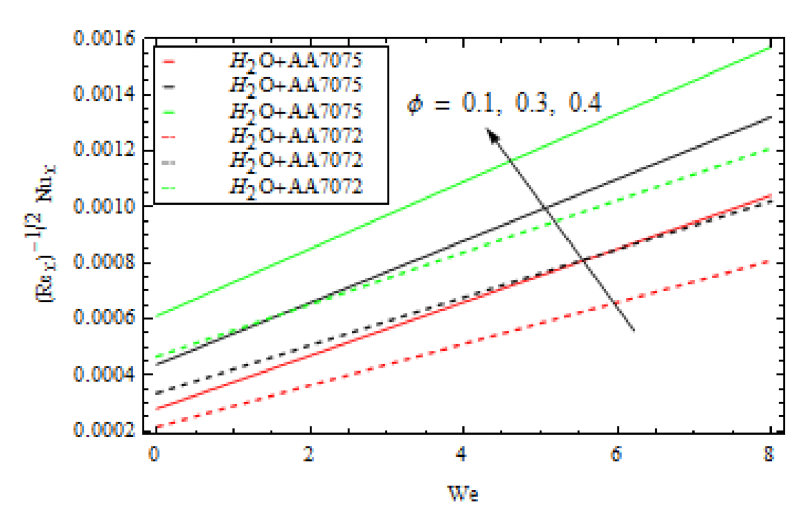
Figure 17. Various values of δ e versus We.